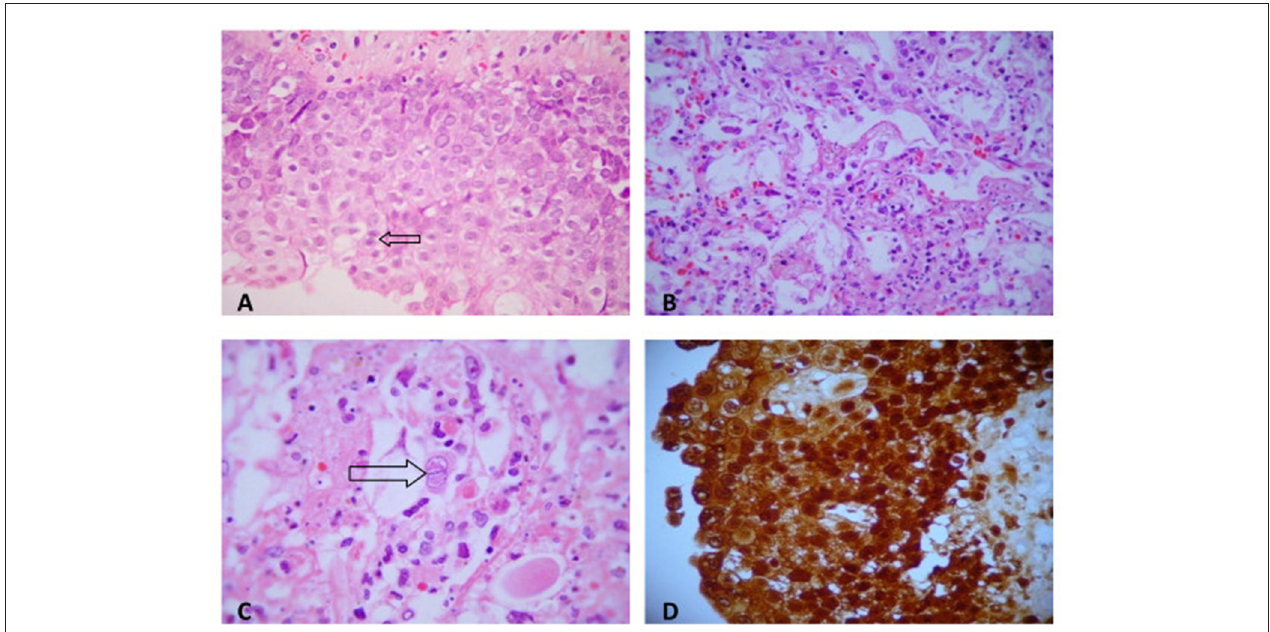
FIGURE 3 | (A) Herpetic pharyngitis: numerous intranuclear viral inclusions in squamous epithelial cells (H&E, × 200). (B) Herpetic necrotizing pneumonitis (H&E, × 200). (C) Intranuclear herpetic inclusions in a pneumocyte (H&E, × 400). (D) Herpes simplex (immunohistochemistry). Numerous cells are strongly immunostained for herpes antigen within cytoplasma (peroxidase antiperoxidase stain, ×